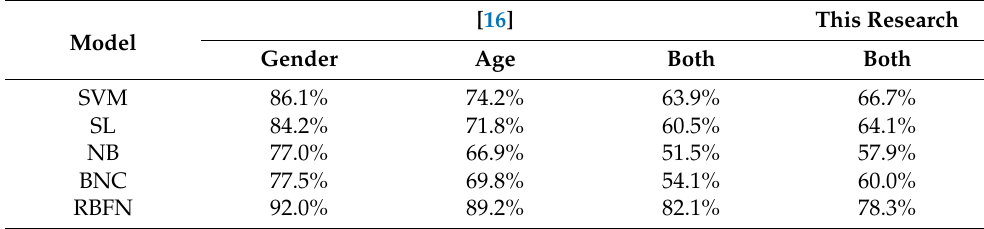
Table 11. Accuracy comparison between research